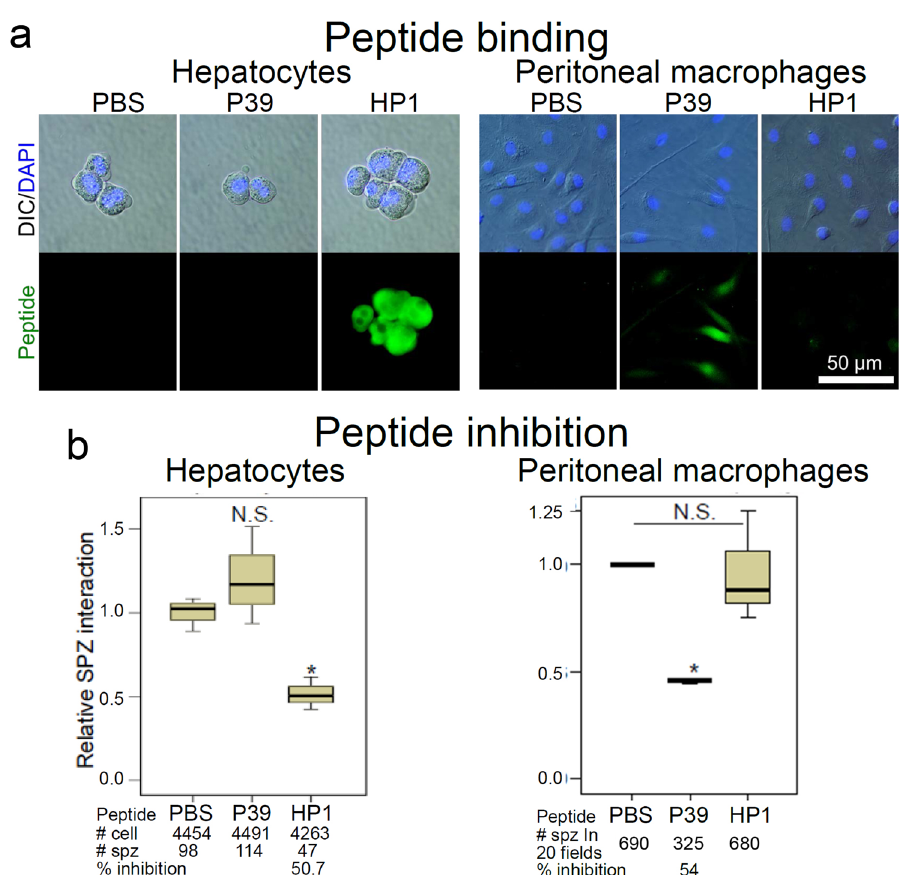
Fig. 2 The synthetic HP1 peptide speci fi cally targets Plasmodium sporozoite – hepatocyte interaction. a A biotin-tagged HP1 peptide was tested for binding to the surface of primary mouse hepatocytes or primary mouse peritoneal macrophages. Peptide binding was detected with